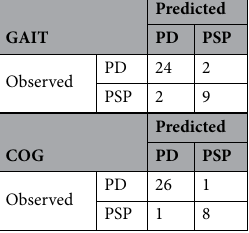
Table 7. Confusion matrix of binary logistic regression (newly diagnosed PD vs early PSP) for GAIT and COG tasks. PD Parkinson’s disease, PSP progressive supranuclear palsy.